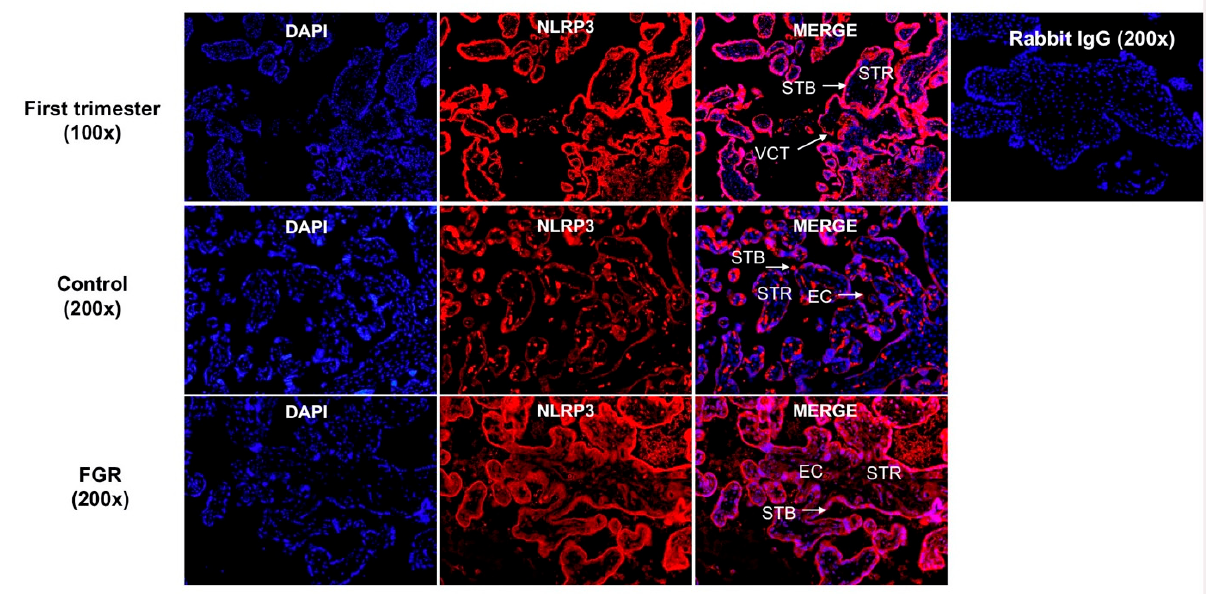
Figure 5. Spatial distribution of NLRP3 in first and third trimester placental tissues. NLRP3 protein localization in first trimester placental tissues (7 weeks of gestation) shows the presence of immunoreactive NLRP3 protein in the villous cytotrophoblasts (VCT), syncytiotrophoblast (STB), and in some stromal cells (STR). Image represents a 100 × magnification. Representative images of term control and term FGR placental tissues for NLRP3 immunostaining in STB, STR, and in endothelial cells (EC) surrounding the fetal capillaries in both control and FGR placentae. Image represents a 200 × magnification. Rabbit IgG was used as a negative control. Scale bar represents 100 µm.